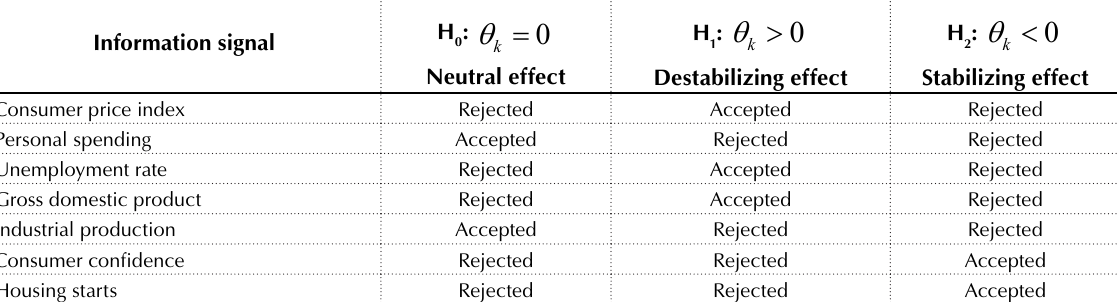
Table 2. The results of testing the hypotheses H component of the “surprise” of non-monetary information signals on the PFTS stock